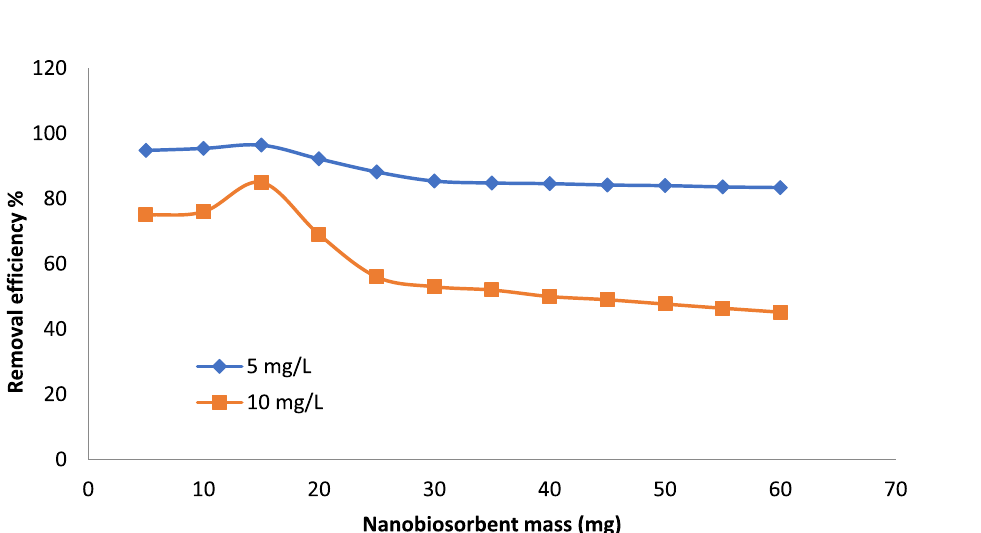
Figure 4. Influence of Gel@GO-F-ZrSiO 4 @Gel mass on biosorptive removal of BF dye. Removal efficiency values (%) are based on triplicate analysis with ± 0.3–0.8% (mass = 5–60 mg, dye volume = 20 mL, dye concentration = 5 and 10 mg L -1 , shaking time = 30 min and centrifugation time = 20